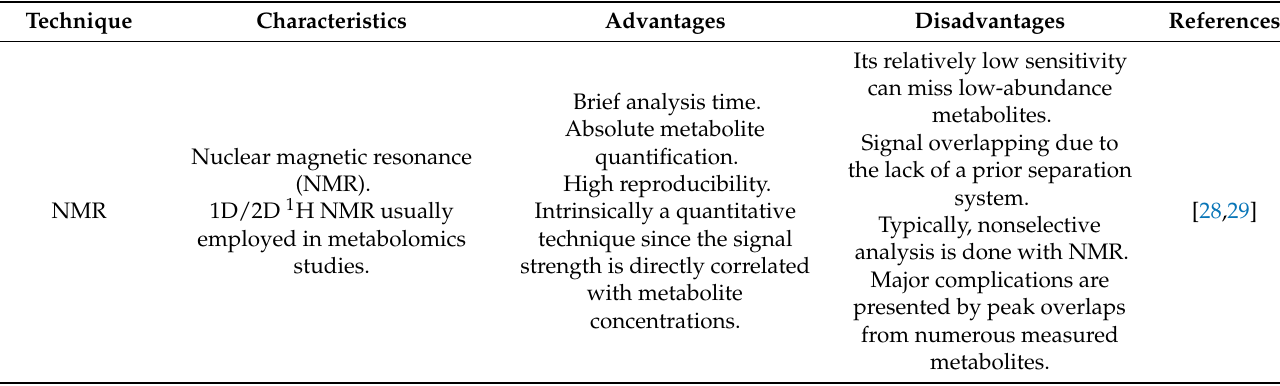
Table 1. Metabolomics analytical